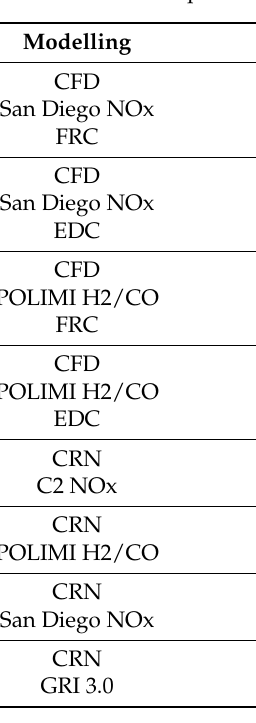
Table 3. Simulations performed to each of the considered conditions.